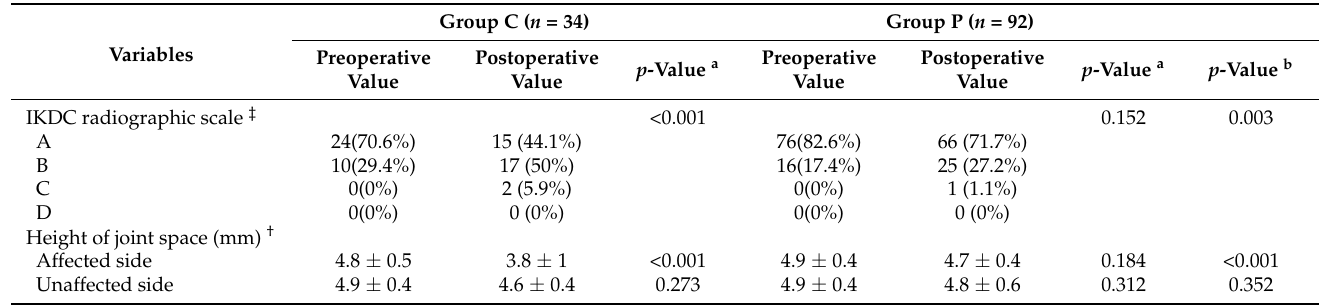
Table 4. Comparison of radiologic outcomes between the preoperative and postoperative values in each group.